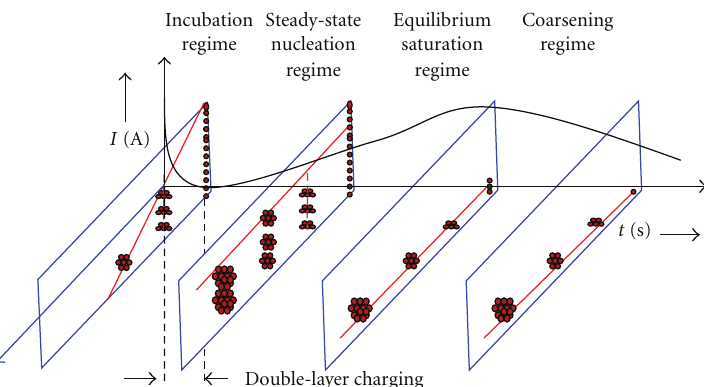
Figure 10: A typical chronoamperogram.